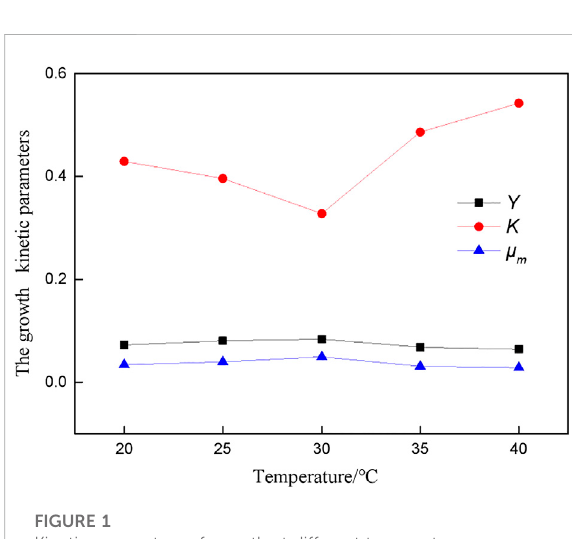
FIGURE 1 Kinetic parameters of growth at different temperatures.